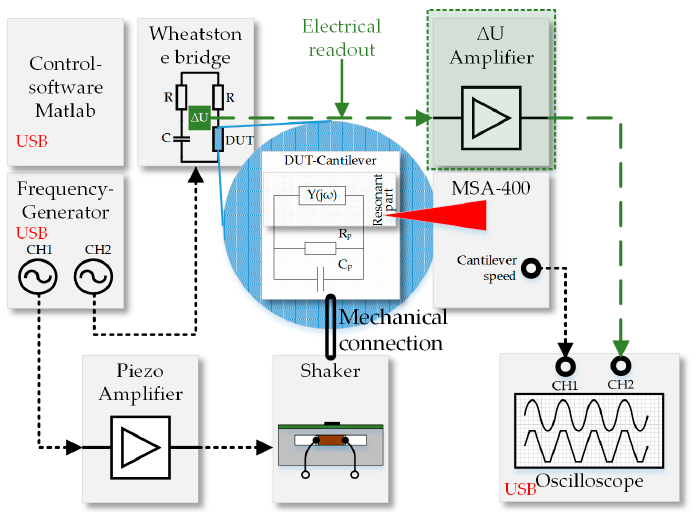
Figure 3. The Block diagram of the measurement set-up used for characterization of the actively damped MEMS cantilevers. The electrical readout, highlighted in green, is targeted for future evaluation purposes.